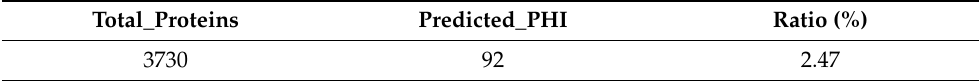
Table 3. Annotation of pathogen-host interaction